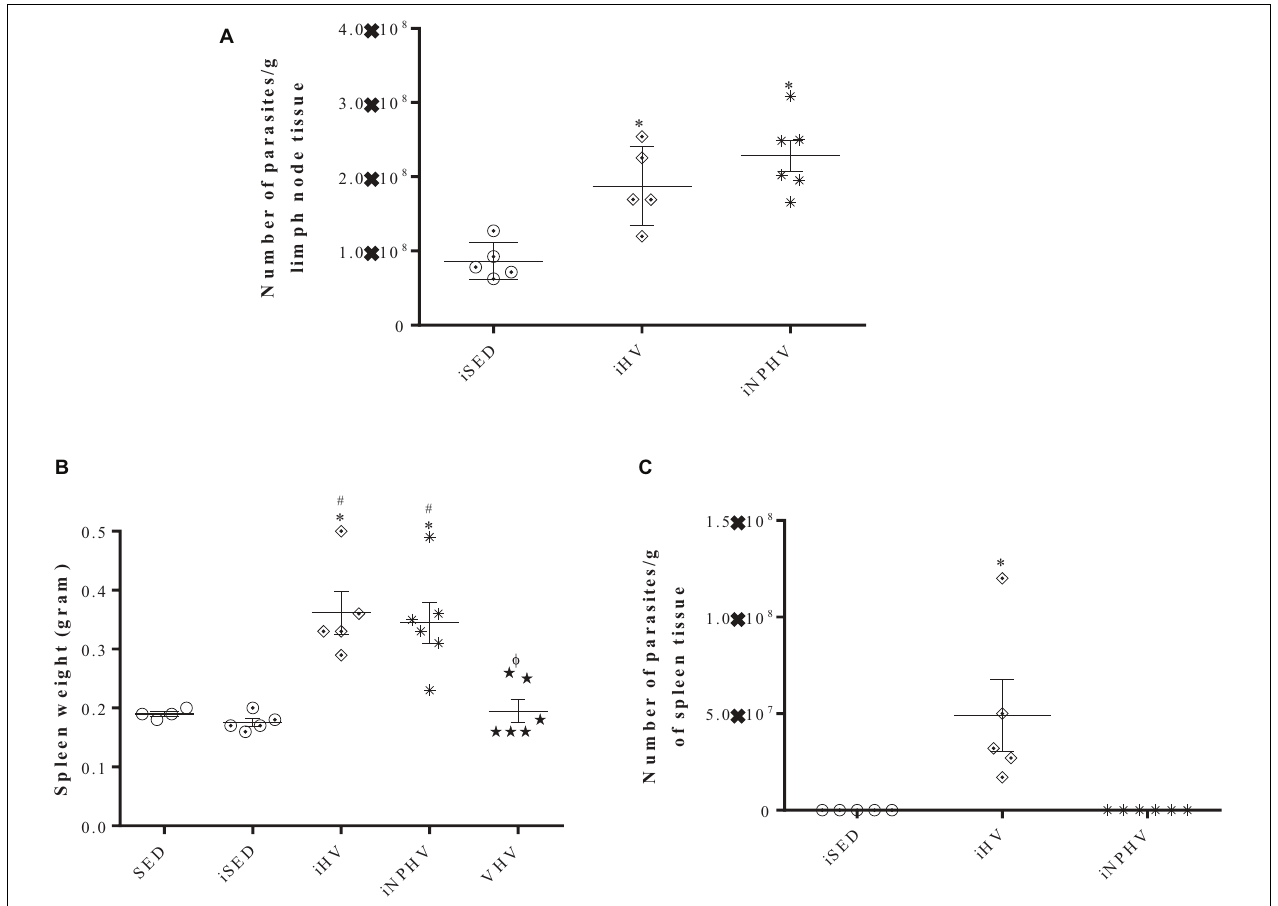
FIGURE 5 | Effect of physical training on the parasite load of lymph nodes (A) and on the visceralization of leishmaniasis by L. major in BALB/c mice (presence of parasites in the spleen of infected mice) (B,C) . The parasites were isolated from lymph nodes and spleens after 12 weeks of infection and quantified by limiting dilution in Schneider’s medium plus 20% FBS. (A) After isolation, there was growth of the sedentary control system (iSED) in the last dilution after 24 h of incubation, when all groups were quantified and the number of parasites was divided by the lymph node weight (in grams). (B) Weight of spleens. (C) After isolation, there was growth of promastigotes in the iHV group after 4 days of incubation; the parasites were quantified by counting in a Neubauer chamber and its number was divided by the weight (in grams) of the spleen. The plates were kept at 26 ◦ C during 14 days to verify the parasite growth in the iSED and iNPHV groups. Values represent mean and bars represent standard error. In panel (A) , ∗ P < 0.0006 in relation to iSED. In panel (B) , ∗ P < 0.0001 in relation to SED; # P < 0.0001 in relation to iSED. (cid:56) P < 0.0001 in relation to groups iHV and iNPHV. In panel (C) , ∗ P < 0.0057 in relation to sedentary control (iSED) and iNPHV. Groups: sedentary control (SED), very high volume (VHV), infected sedentary control (iSED), infected high volume (iHV), and infected non-periodized high volume (iNPHV).